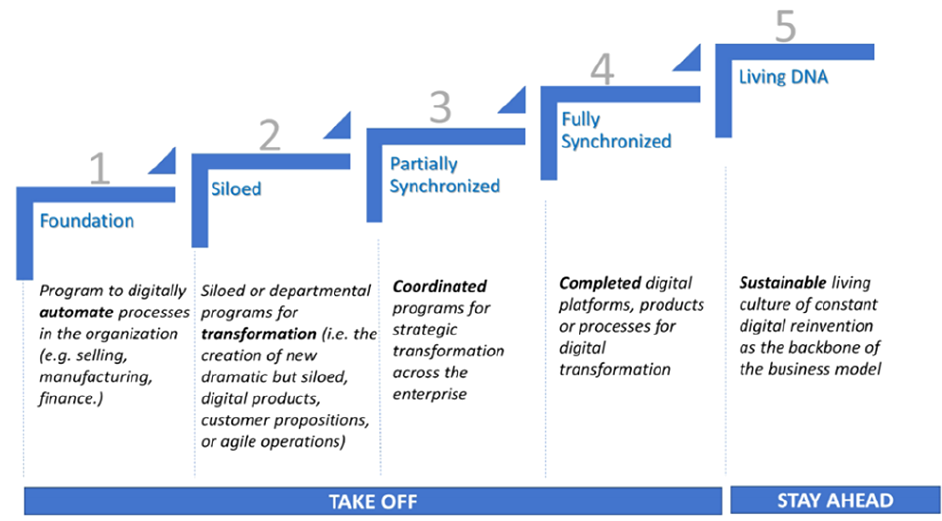
Figure 8. The five stage model for successful digital transformation [88].